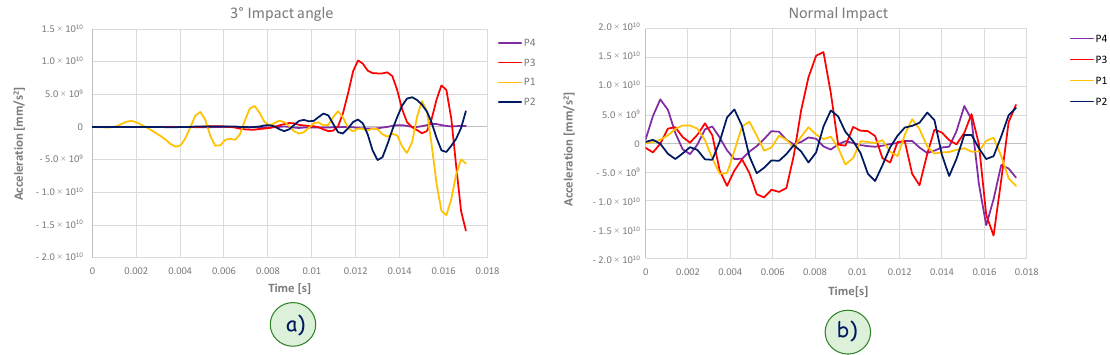
Figure 13. Acceleration of four different points: ( a ) 3° impact angle; ( b ) normal impact.